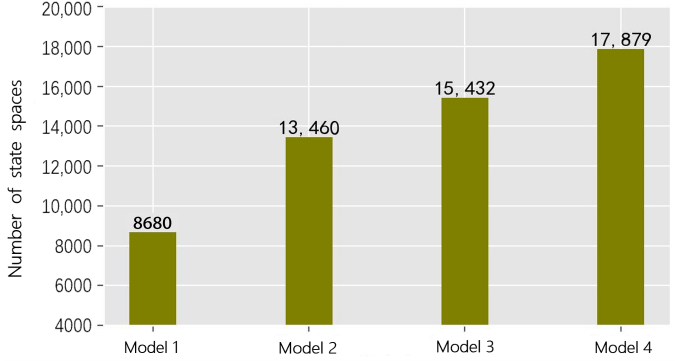
Figure 7. Number of state spaces for the four models.